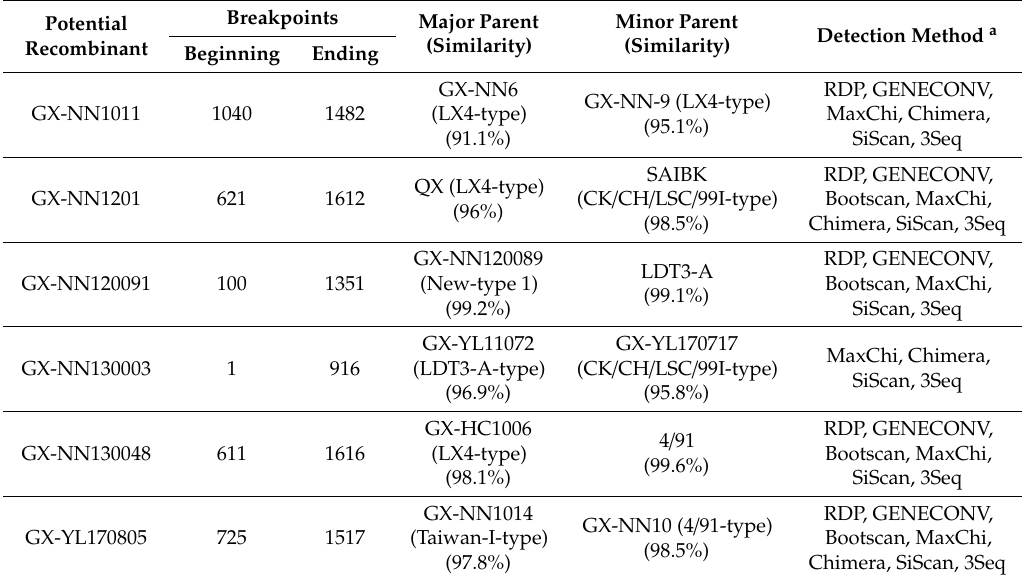
Figure 3. Recombination Detection Program (RDP) screenshots displaying the possible recombination events on the isolates ( a ) GX-NN1011, ( b ) GX-NN1201, ( c ) GX-NN120091, ( d ) GX-NN130003, ( e ) GX-NN130048, and ( f ) GX-YL170805. The highly similarity ( > 0.95) regions with putative parental fragments was show in dark gray area, and pink box indicated the recombinant origin with putative parental strains. Table 2. Genetic recombination events of IBV isolates detected by RDP 4 software